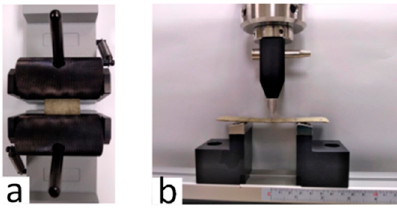
Figure 3. Mechanical tests performed on bio-composite sheets ( a ) tensile strength and ( b ) bending strength.